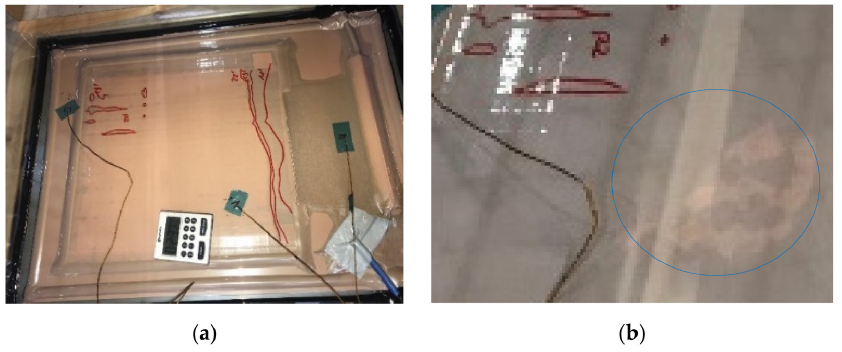
Figure 7. ( a ) VAP-Infusion–measurement of the infiltration time, wet spots, and flow front are marked, position of temperature sensors. ( b ) Infusion briefly before entire impregnation; the last dry spot is